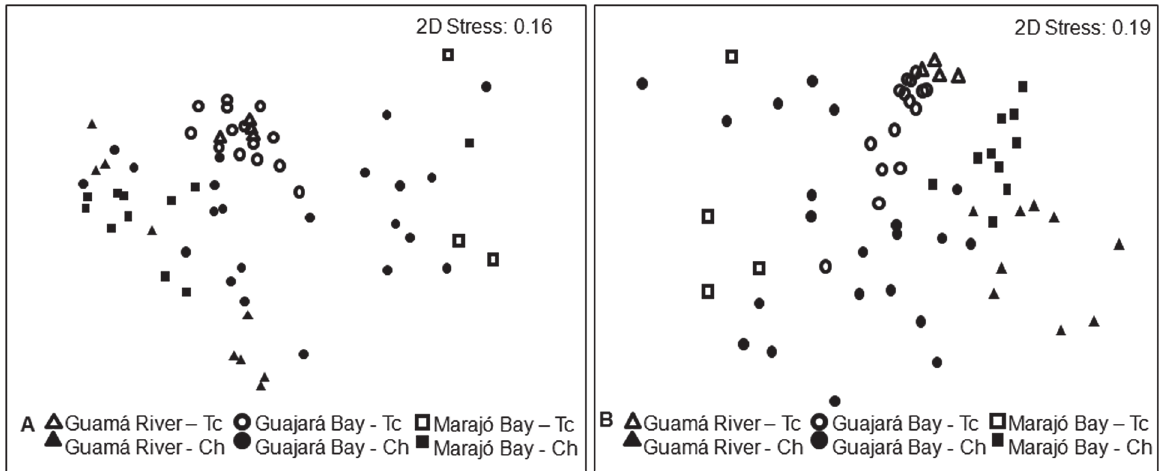
Figure 3 - Multivariate multidimensional scaling analysis by zone (Guamá River, Guajará Bay and Marajó Bay) and environment (Main channel and Tidal creek): A) abundance percentage and B) biomass